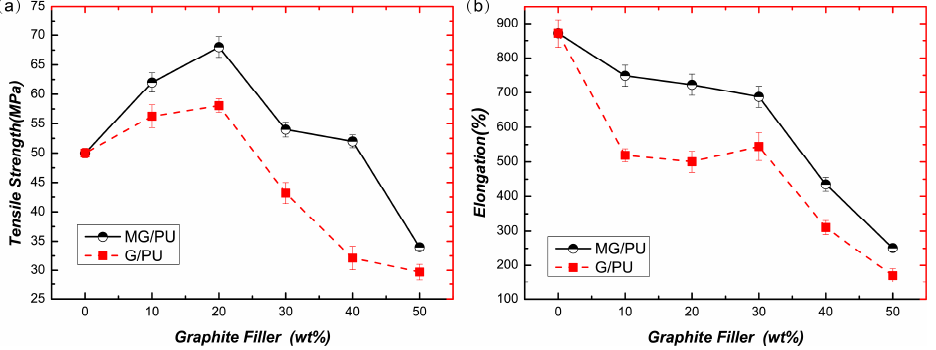
Figure 6. The curves of filler content vs. tensile strength ( a ) and elongation at break ( b ) for the MG/PU composites and G/PU composites.